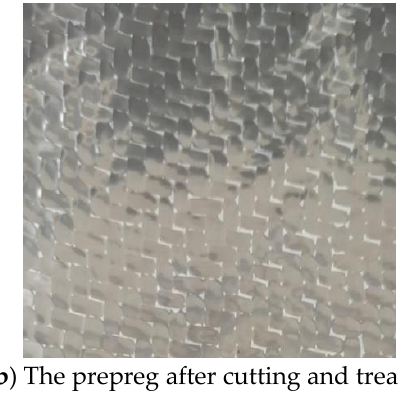
Figure 1. The prepreg.